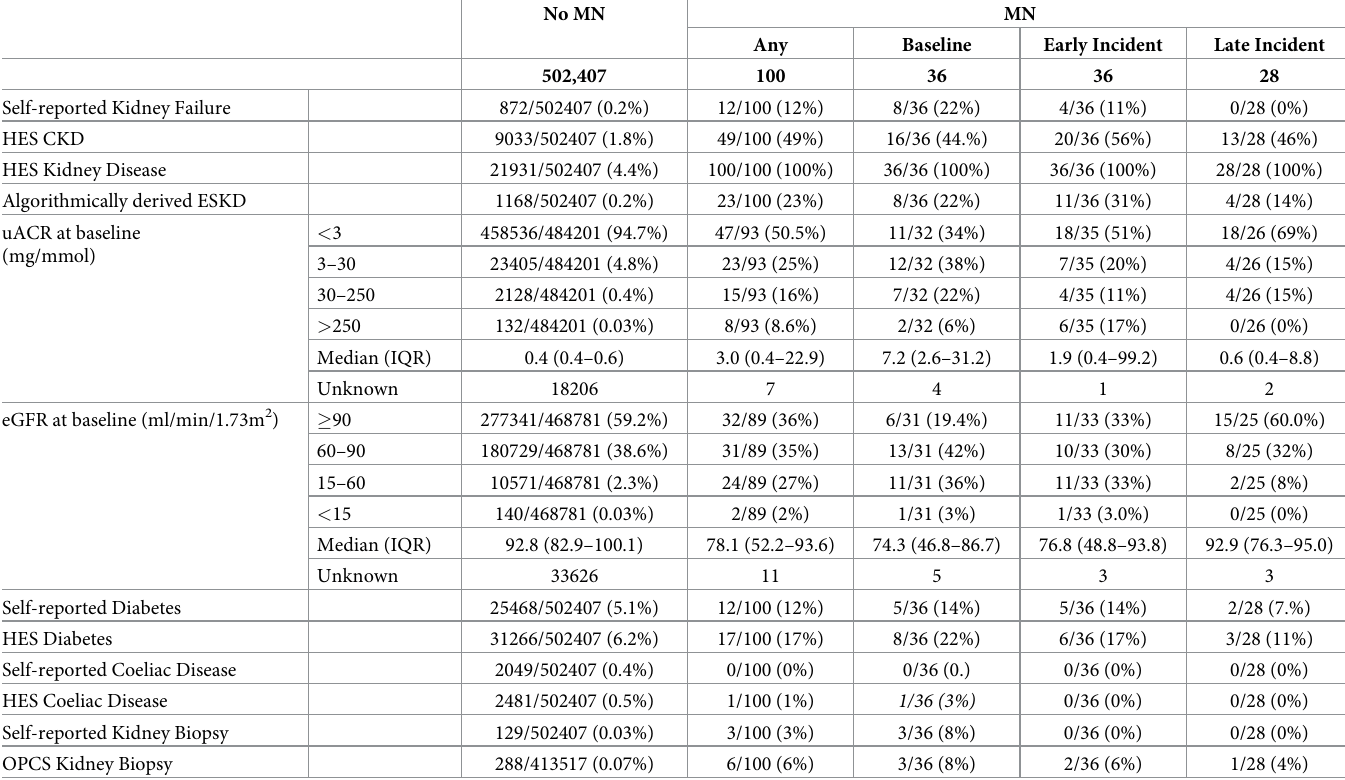
Table 3. Phenotype per group.